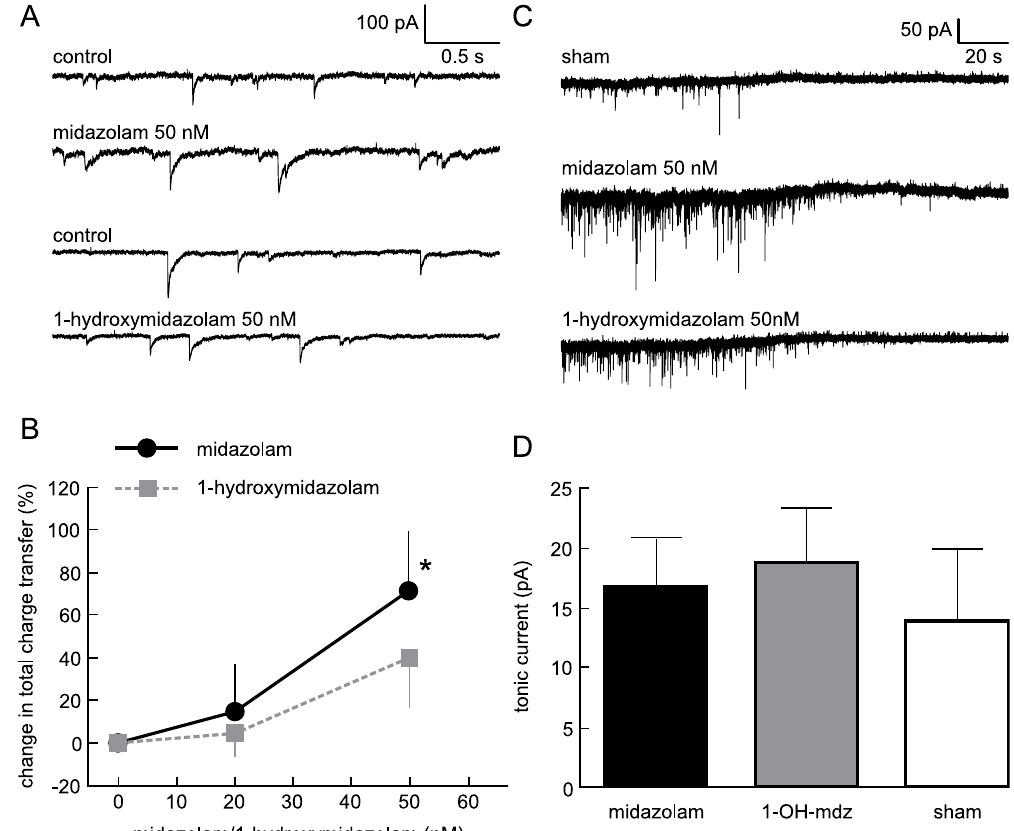
Figure 5. Effects of midazolam and 1-hydroxymidazolam on phasic and tonic currents of cultured cortical neurons. ( A ) Raw traces from two example whole cell recordings in neocortical neurons are displayed. Upper two traces: Control condition and presence of 50 nM midazolam. Midazolam induced a slight broadening, a slight increase in amplitude and a slight increase in frequency of IPSCs. Lower two traces: Control condition and presence of 50 nM 1-hydroxymidazolam. The effect of 1-hydroxymidazolam resembles the combined effect of midazolam, but overall was less pronounced. ( B ) Summary of the actions of midazolam and 1-hydroxymidazolam on IPSCs. The total charge transfer was calculated as area under the curve of the averaged IPSC multiplied by the frequency of IPSCs, normalized to control condition. At 50 nM the effect of midazolam on the total charge transfer is significantly different from sham application (n = 11, p = 0.046), while the effect of 1-hydroxymidazolam is not (n = 15, p = 0.022). ( C ) Raw traces from whole cell recordings illustrating the actions of midazolam and 1-hydroxymidazolam on tonic currents. Each recording shows 180 s starting at the application of 20 µ M bicuculline. Top trace: Sham (ACSF) application plus bicuculline. Middle trace: Application of 50 nM midazolam plus bicuculline. Lower trace: Application of 50 nM 1-hydroxymidazolam plus bicuculline. Note that in each case a small tonic current is visible in the presence of bicuculline. ( D ) Summary of the actions of midazolam and 1-hydroxymidazolam on tonic inhibition. Both, midazolam and 1-hydroxymidazolam at a concentration of 50 nM induced a tonic current in cultured cortical neurons in the presence of 20 µ M bicuculline. However, tonic currents by midazolam (n = 9) and 1-hydroxymidazolam (n = 12) were not significantly different from sham application (n =